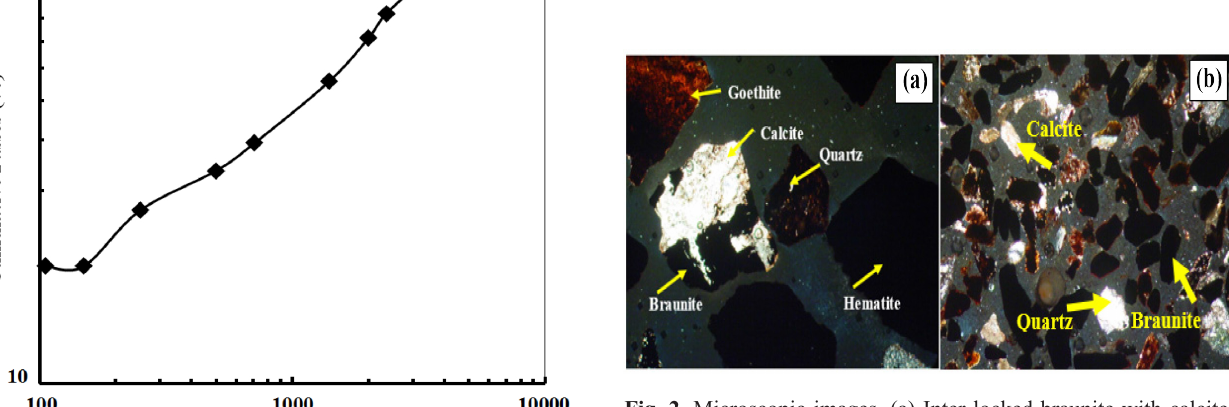
Fig. 2. Microscopic images. (a) Inter-locked braunite with calcite, quartz, clay mineral and (b) Particles liberated in size fraction -150